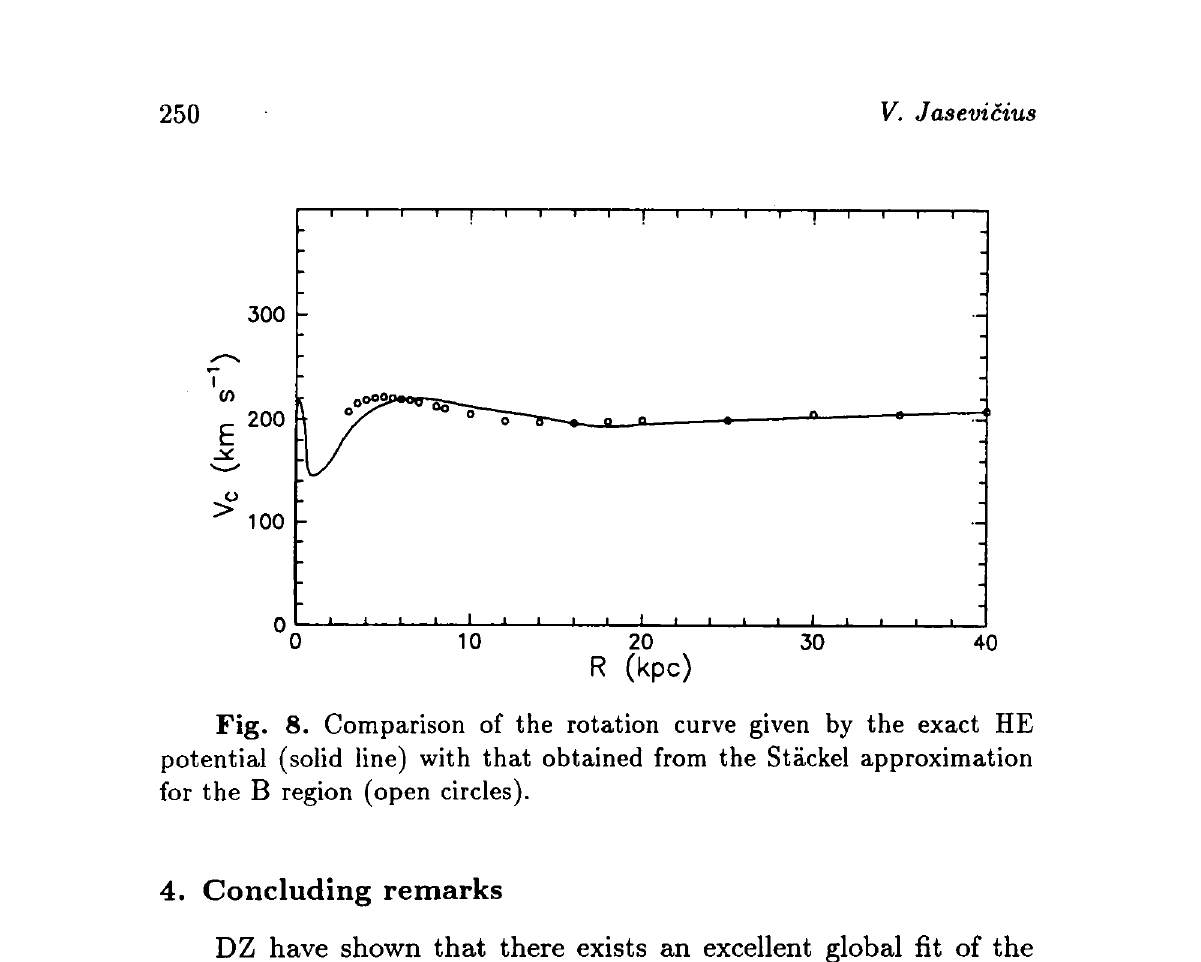
Fig. 8. Comparison of the rotation curve given by the exact HE potential (solid line) with that obtained from the Stackel approximation for the B region (open